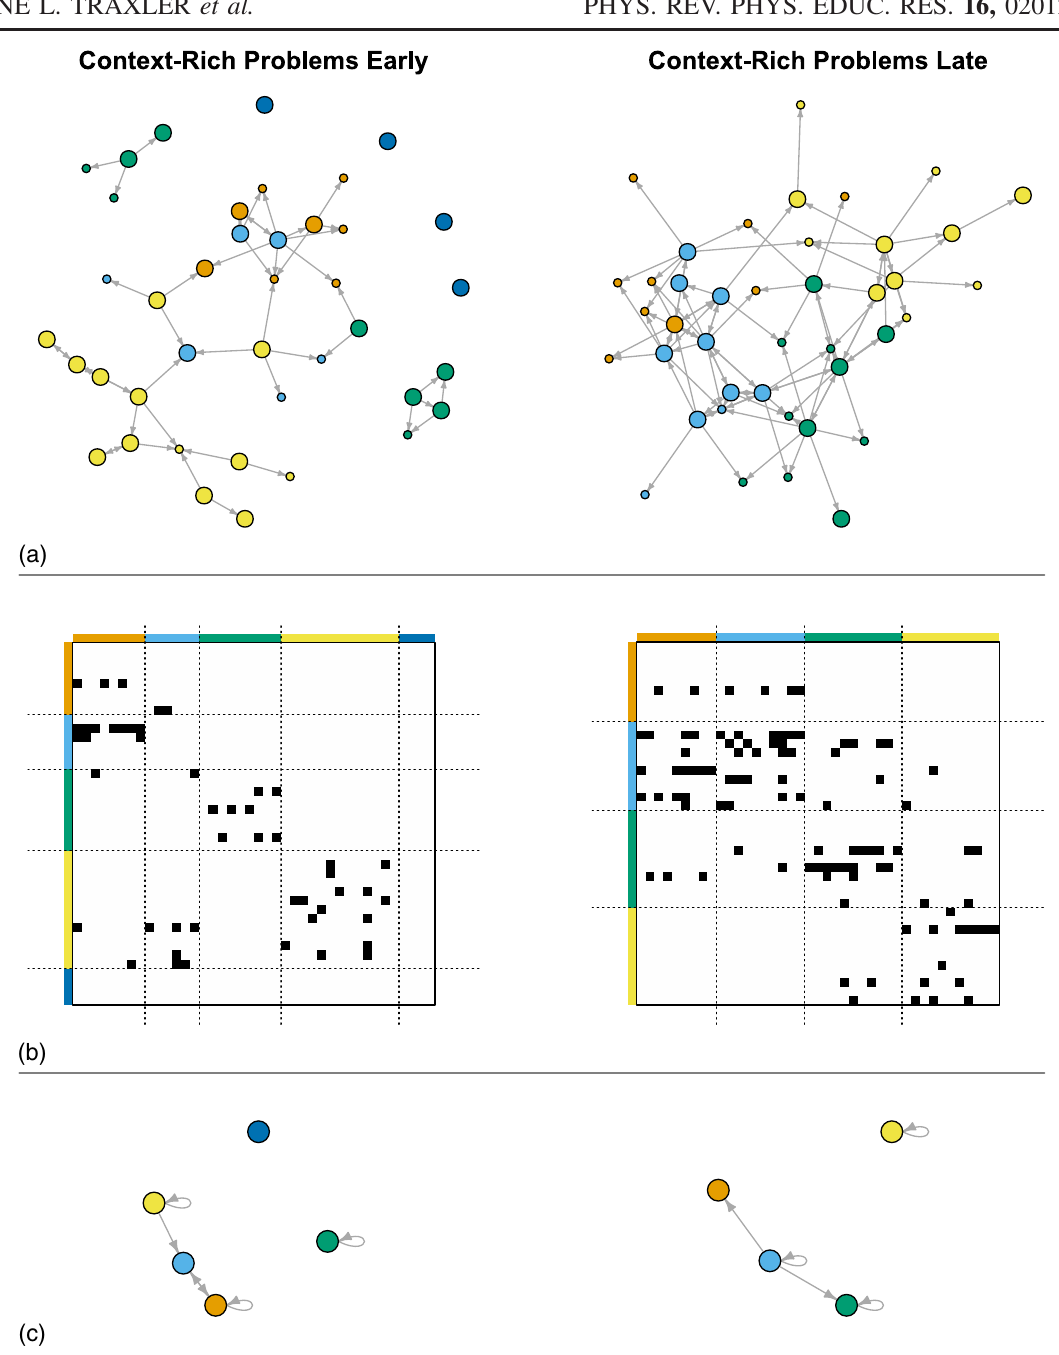
FIG. 6. (a) Network diagrams, (b) blockmodels, and (c) reduced network diagrams for context-rich problems section. Smaller circles on the network diagrams are students who did not take the survey but were named by respondents. Nodes are colored by CONCOR partition, and dotted lines on the blockmodel plots show the same